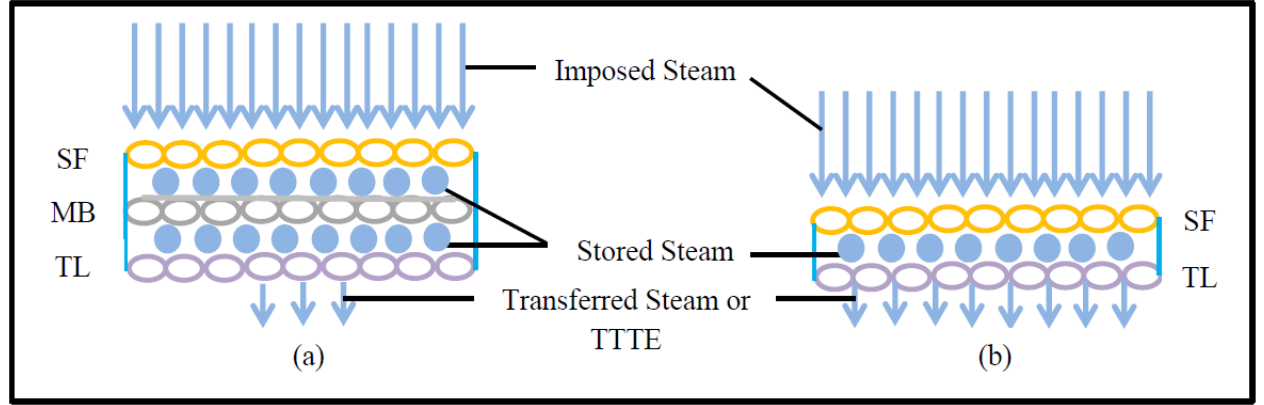
Figure 3. TTTE through ( a ) triple-layered and ( b ) double-layered fabric systems.